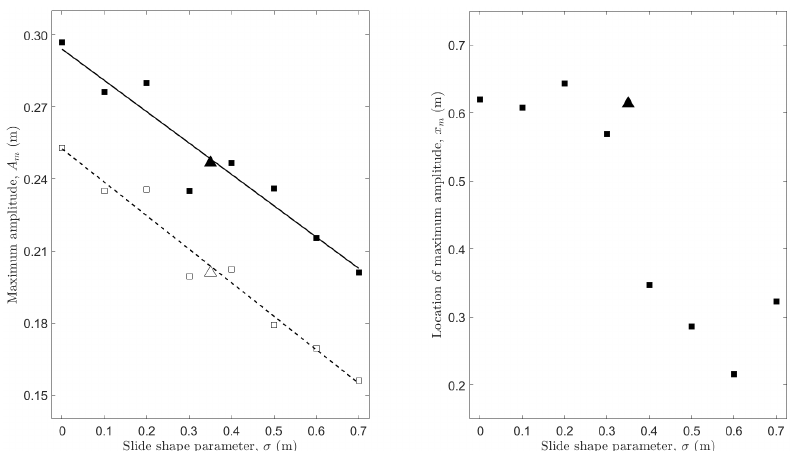
Figure 7. Effects of slide shape on maximum wave amplitude. ( Left ) amplitude against slide shape parameter σ ( (cid:4) : maximum amplitude A m ; (cid:3) : amplitude measured at x = 1 m; —: fitted regression line for (cid:4) ; ---: linear fit for (cid:3) ). ( Right ) location of the maximum amplitude, x m . In both panels, triangles represent the results by the reference solid slide used in the laboratory testing.